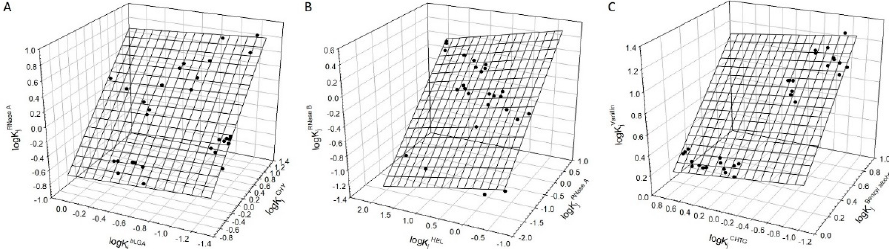
Figure 2. ( A ) Linear relationship between logarithms of partition coefficients of -chymotrypsin (CHY), -lactoglobulin A (bLGA), and ribonuclease A (RNase A) in various aqueous two-phase systems (Data from Table S2, Supplementary Information). The plane corresponds to Equation (1). Error bars are the same size as/or smaller than the symbols. ( B ) Linear relationship between logarithms of partition coefficients of ribonuclease A (RNase A), lysozyme (HEL), and ribonuclease B (RNase B) in various aqueous two-phase systems (Data from Table S2, Supplementary Information). The plane corresponds to Equation (1). Error bars are the same size as/or smaller than the symbols. ( C ) . Linear relationship between logarithms of partition coefficients of benzyl alcohol, - chymotrypsinogen (CHTG), and vanillin in various aqueous two-phase systems (Data from Table S2, Supplementary Information). The plane corresponds to Equation (1). Error bars are the same size as/or smaller than the symbols.